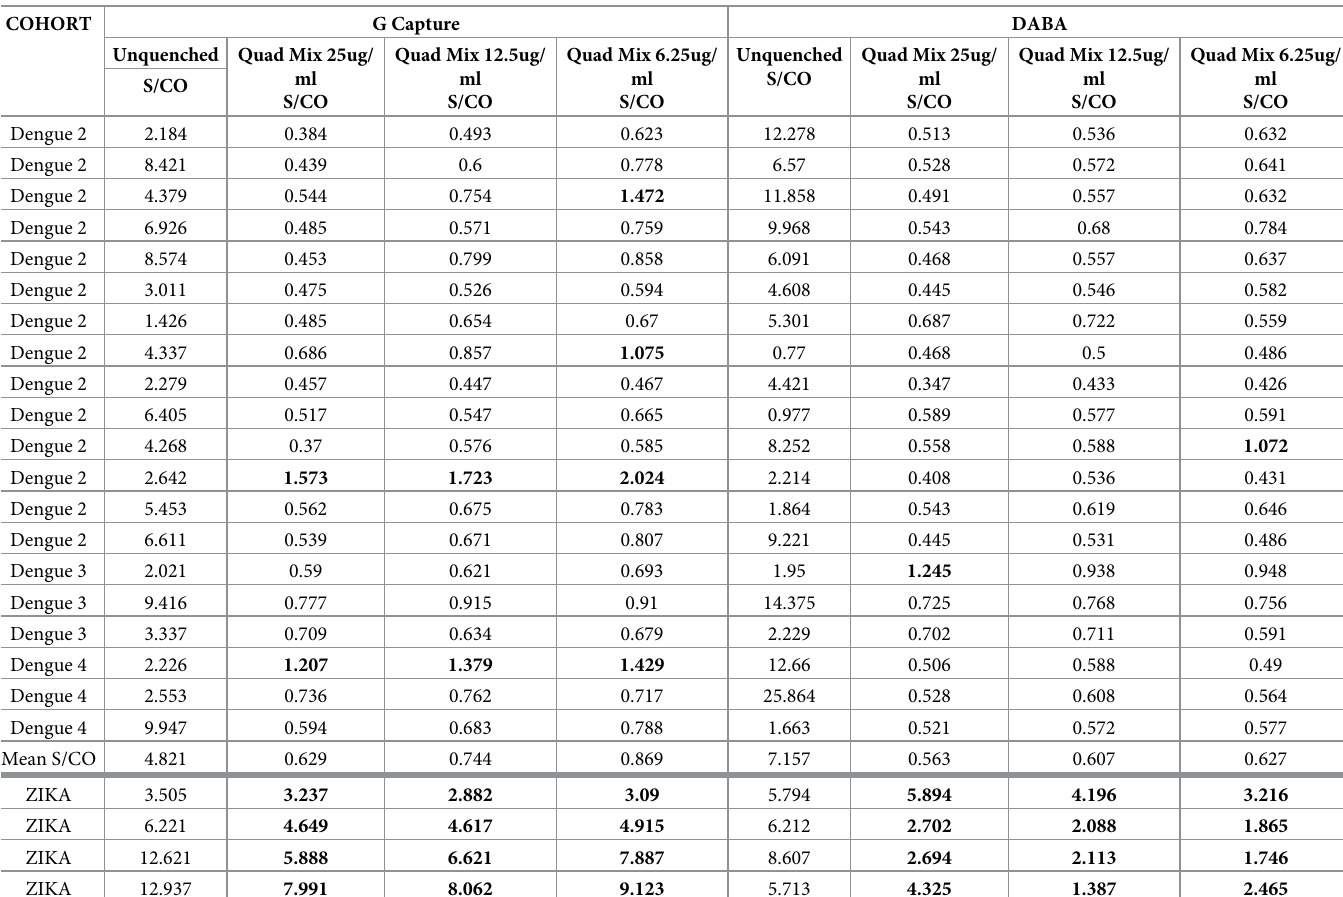
Table 3. Titration of un-labelled competitor homologue quadrivalent DV NS1 quench.